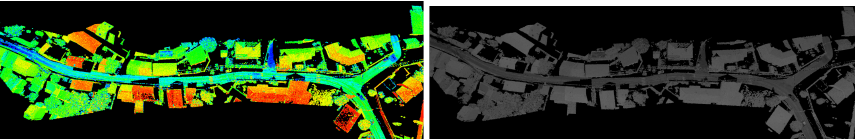
Figure 10. ( Left ) Intensity gradient with modified min/max cutoff range, ( Right ) intensity value in grayscale.